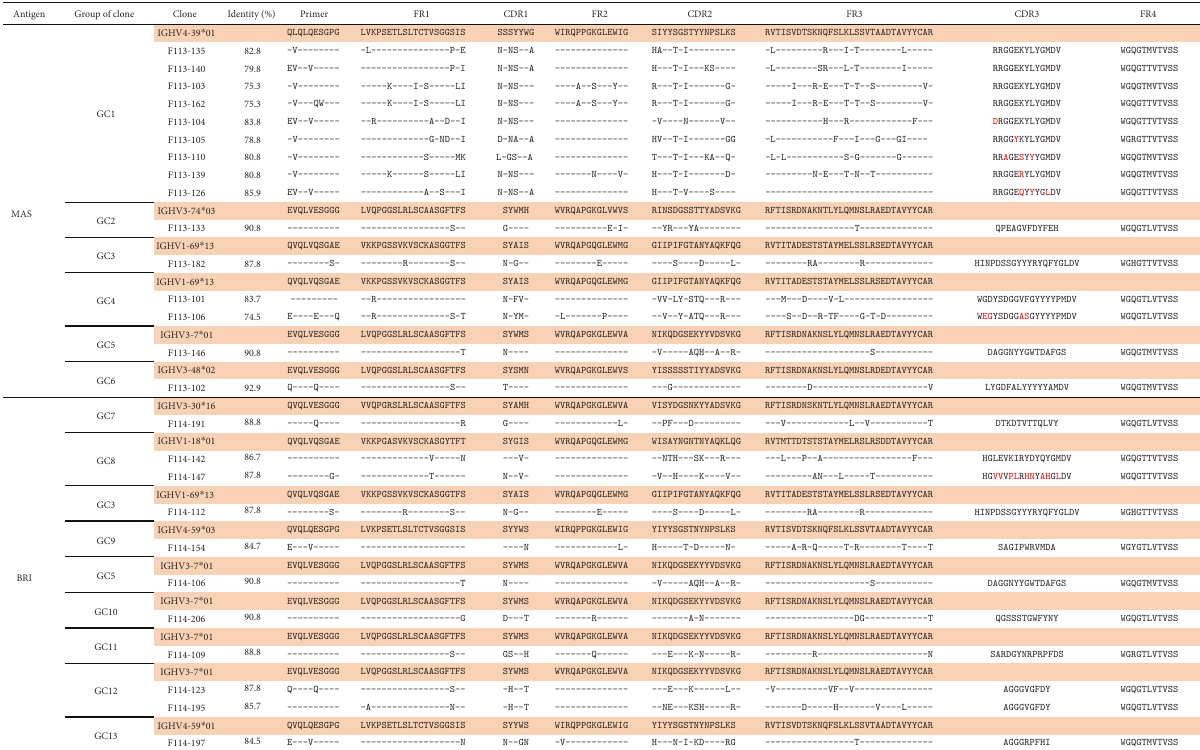
genes in the respective clones were H